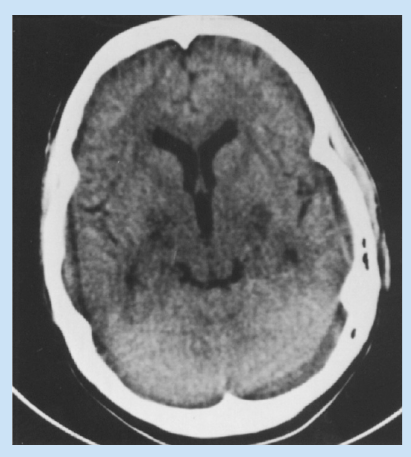
Fig. 2. Contrast-enhanced image, showing bilater- al enhancing lesions in the internal capsule.